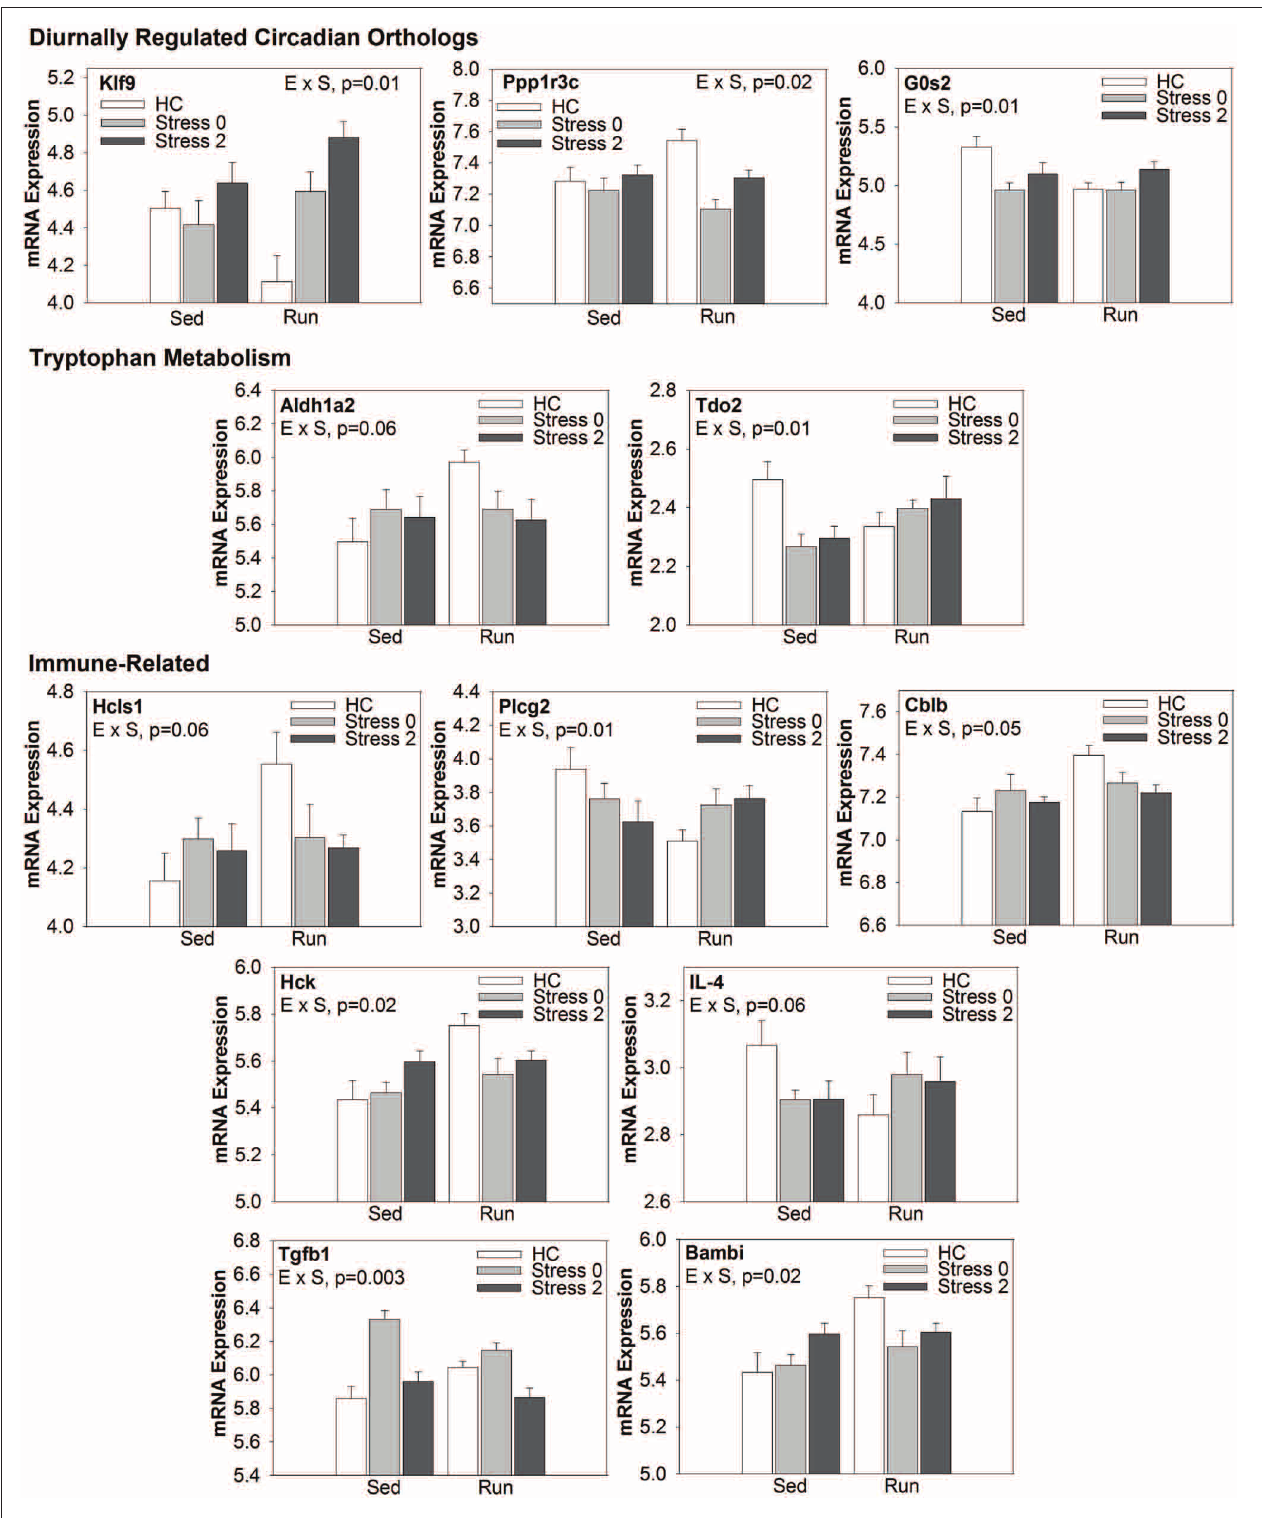
FIGURE 4 | Effect of exercise on stress-induced alterations in the expression of select genes in the DRN, organized by Wiki functional category.